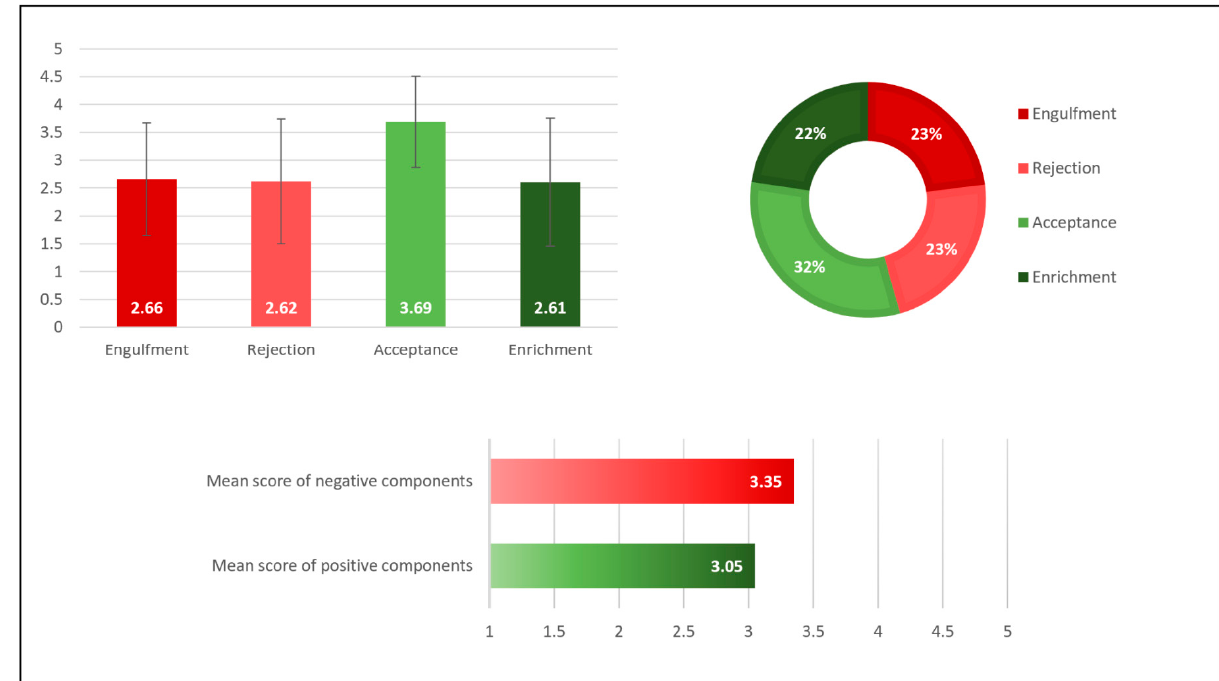
Figure 1. Illness Identity Components and Profile of the Adults with Autism Spectrum Disorder.